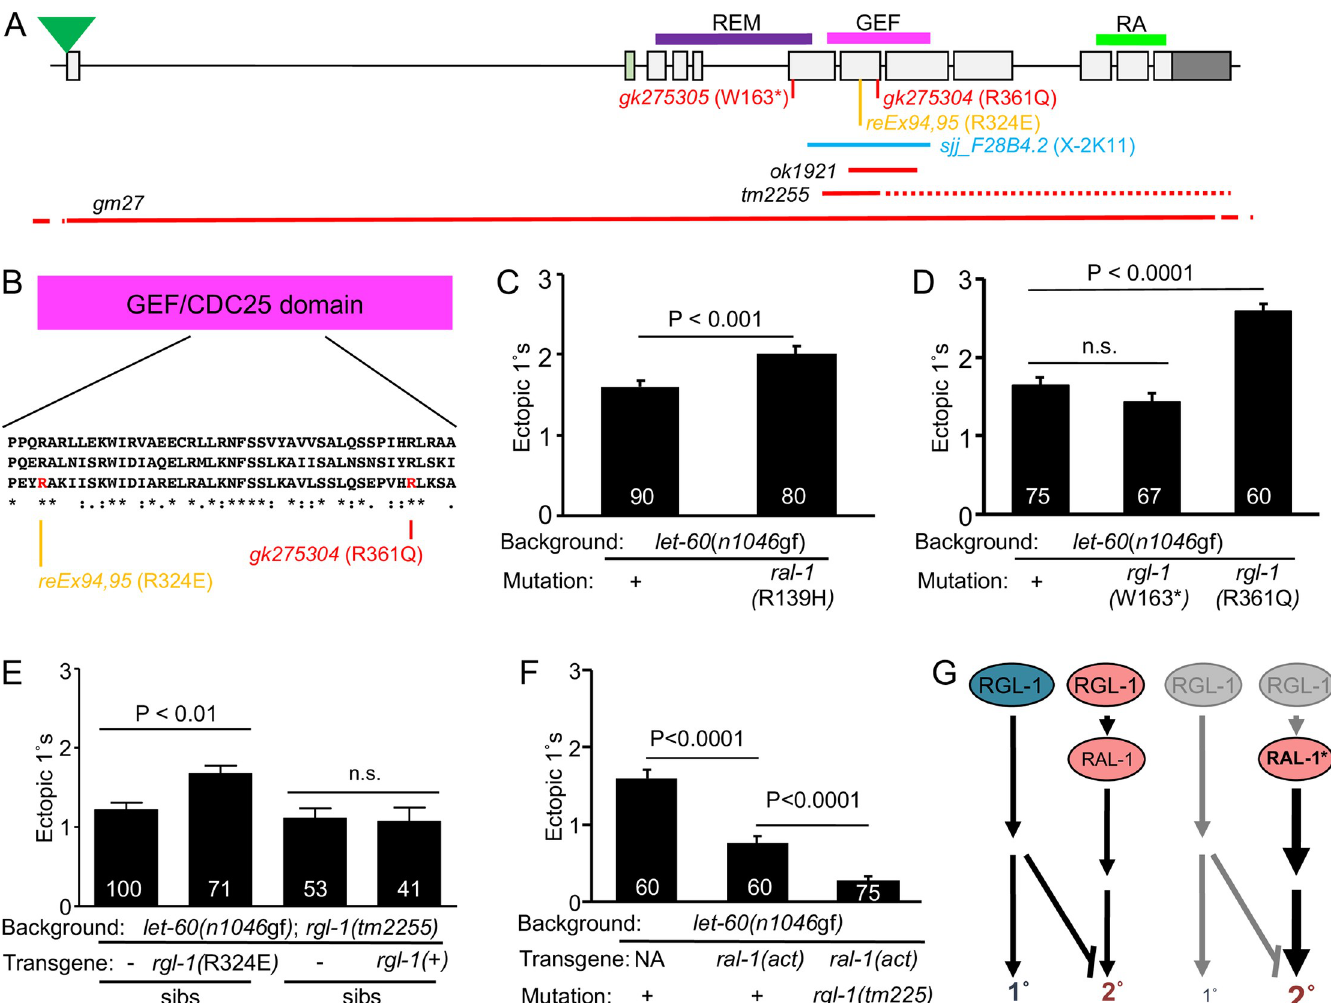
Fig 4. RGL-1 encodes genetically separable functions. A) A schematic of the rgl-1 gene and genetic reagents for this analysis. Green triangle = mNeonGreen::3xFlag tag by CRISPR (S3 Fig). Light green exon 2: by RNAseq this is a rare mRNA species, and the 20 residues coded for by Exon 2 are not conserved among Drosophila and mammalian RalGEFs. Purple, pink and bright green lines: REM, GEF and RA (Ras Association) domains (The REM domain is a structural component of some but not all Ras family GEFs). Red gk alleles: W163 � and R361Q mutations from the million mutation project. Orange: canonical R324E GEF-deficient mutation in transgenes reEx94 and reEx95 . Light blue: coverage of bacterially mediated RNAi clone (library location; [54]). Red lines: sequences deleted by ok1921 , tm2255 and gm27 deletions (dotted line indicates that deletion ends out of frame). B) An alignment of a portion of the RalGEF domain containing the canonical GEF-deficient R324E and gk275304 R361Q mutations (top to bottom: Human RGL2, in which the GEF-deficient mutation was validated, fly RalGEF, C . elegans RGL-1). C) The ral-1(gk628801 rf ) R139H missense mutation enhances 1˚ induction in the let-60(n1046 gf ) background. Data shown were scored concurrently and are representative of two assays. D) rgl-1 mutation gk275304 (R361Q) but not gk275305 (W163 � ) enhances 1˚ induction in the let-60(n1046 gf ) background. Data shown were scored concurrently and are representative of two assays. E) Transgenic rescue of rgl-1(tm2255) in the let-60(n1046 gf ) background. Transgenic array-bearing animals harboring P with P myo-2 :: gfp co-injection marker and their non-array-bearing siblings were scored. The reEx94 (shown) and reEx95 (P < 0.006, N = 96 and N = 88) R324E mutant transgenes enhanced 1˚ induction relative to their non-transgenic siblings, as scored in separate concurrent assays for each array, suggesting that a GEF-independent 1˚- promoting activity of RGL-1 functions cell autonomously in the VPCs. ( reEx94 rgl-1(R324E) mutant transgenic animals failed to respond to ral-1(RNAi) , S4C Fig) The reEx109 (shown) and reEx110 (also n.s., N = 63 and N = 57) wild-type transgenes failed to alter 1˚ induction relative to their non-array-bearing siblings, as scored in separate concurrent assays for each array, suggesting that the GEF-dependent 2˚-promoting activity of RGL-1 also functions cell autonomously in the VPCs. ( reEx109 rgl- 1 ( + ) transgenic animals responded to ral-1(RNAi) , S4D Fig) F) reIs10[P lin-31 :: ral-1A(Q75L) , P myo-2 :: gfp] (“ ral-1(act) ”) suppressed ectopic 1˚ induction in the let-60 (n1046 gf ) background; in a single concurrent assay, 1˚ induction was further suppressed by rgl-1(tm2255) , revealing an opposing RGL-1 signal that may be 1˚- promoting. Further validation of reIs10 “ ral-1(act) ” shown in S4B Fig. Data are the mean ± standard error of the mean (SEM). For statistical reasons single, non-pooled assays are shown, and white numbers represent animals scored therein. Significance was calculated by Kruskal-Wallis, Dunn test. G) A schematic of the bypass experiment in F . Left: canonical and non-canonical RGL-1 activities are opposed and roughly equivalent (in the backgrounds assayed). Right: constitutive, VPC-specific activation of RAL-1 bypasses the GEF activity while also revealing a GEF-independent function of RGL-1, resulting in increased 2˚-promoting signal and concomitant loss of 1˚-promoting signal, with a net decrease of ectopic 1˚